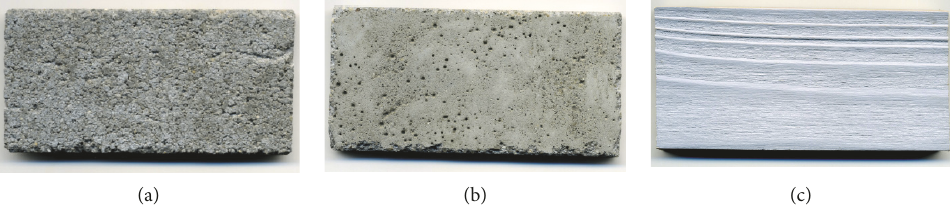
Figure 3: Surface appearance of substrates tested: mortar W/C=0.4 (a), mortar W/C=0.5 (b), and painted wood (c). Surface roughness mean values: 130 μ m, 11 μ m, and 15 μ m for mortar W/C =0.4, mortar W/C =0.5, and wood (see Section